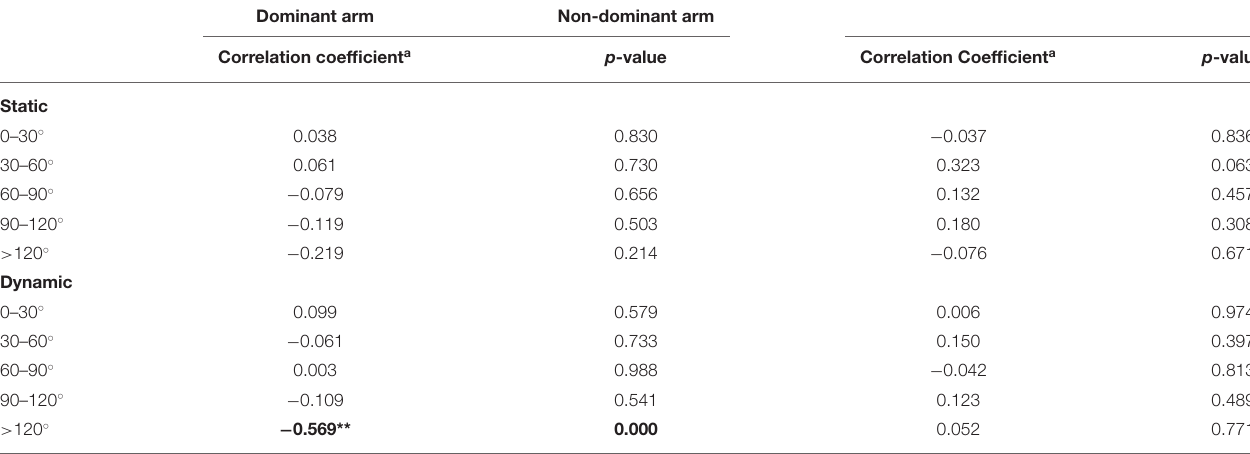
TABLE 6 | The correlation coefficient between PC-WUSPI scores and the average consecutive duration of static and dynamic periods for the dominant and non-dominant arms in each humeral elevation range for the MWC cohort. Dominant arm Non-dominant arm Correlation coefficient a p -value Correlation Coefficient